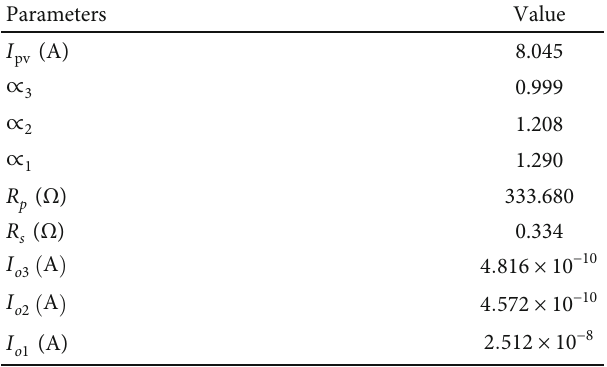
Table 4: Performance evaluation of three-diode PV MLP model.